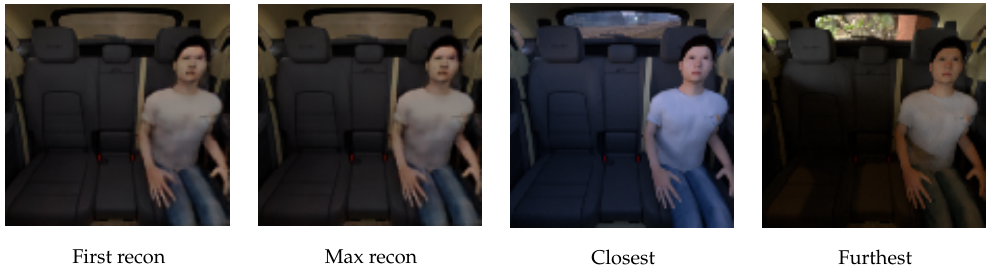
Figure 9. Reconstruction of the first scenery (first recon) is compared against the furthest reconstruction of all sceneries (max recon). First recon is also used to determine the closest and furthest scenery. The model does not learn to focus the reconstruction to a training